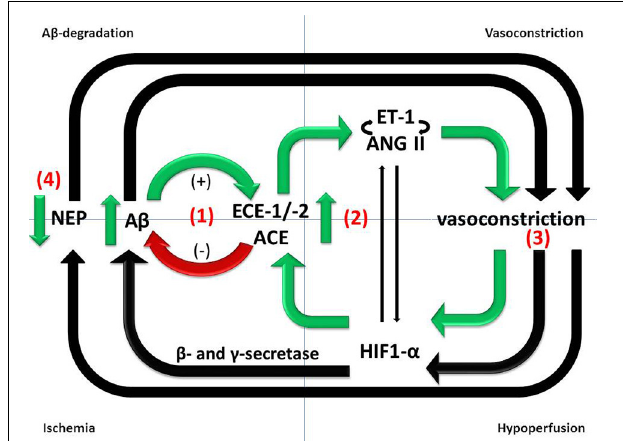
FIGURE 1 | Divergent roles of A β -degrading enzymes in the pathogenesis of AD. (1) ECE-1/-2 and ACE cleave A β in vitro and ECE-1/-2 regulate endogenous A β level in mice. However, ECE-1/-2 and ACE activities are increased in the cerebral cortex in AD in human post-mortem brain tissue. The increases are likely to represent responses to accumulating A β and may mitigate the accumulation but are inadequate to prevent the level of A β from continuing to rise as the disease progresses. (2) Upregulation of ECE-1/2 and ACE by A β results in increased production of ET-1 and Ang II, both of which mediate vasoconstriction. (3) Reduced cerebral perfusion, as a result of vasoconstriction, probably increases A β production by promoting amyloidogenic processing of APP. (4) NEP protects vessels from A β -related pathology, including CAA, but NEP activity is reduced in conditions of hypoxia and oxidative